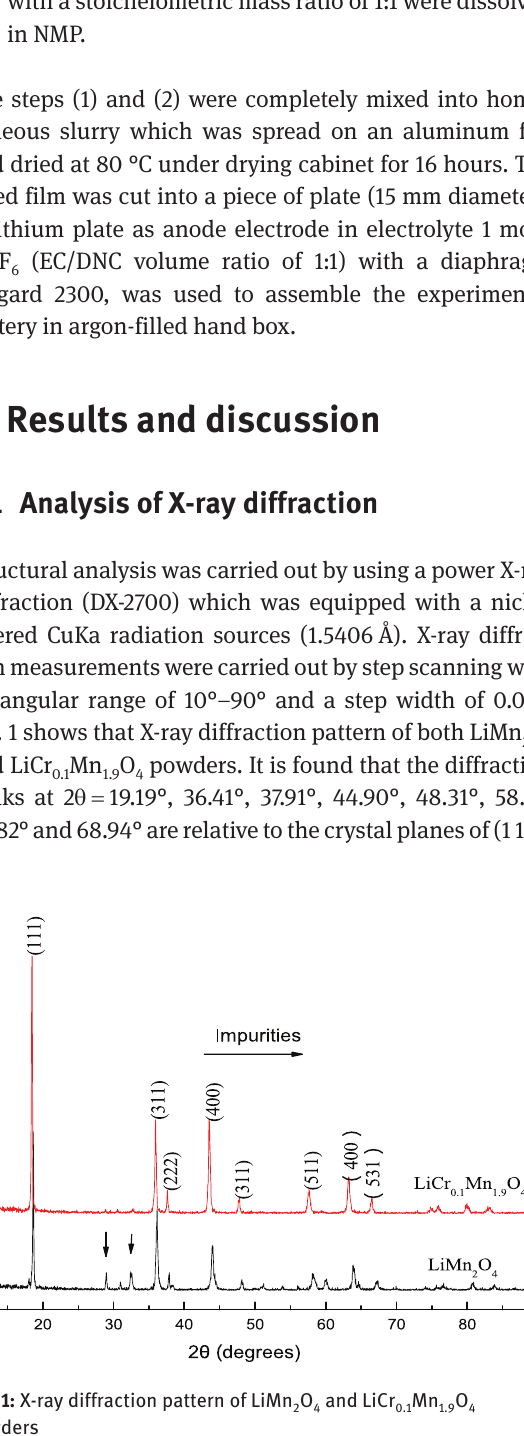
Fig. 1: X-ray diffraction pattern of LiMn 2 O 4 and LiCr 0.1 Mn 1.9 O 4 powders